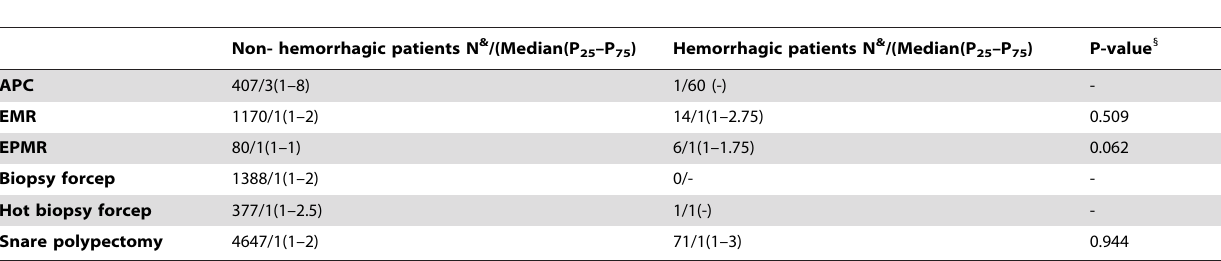
Table 5. Univariate analysis of number of resected polyps for delayed colonic postpolypectomy hemorrhage based on patients and different polypolypectomy